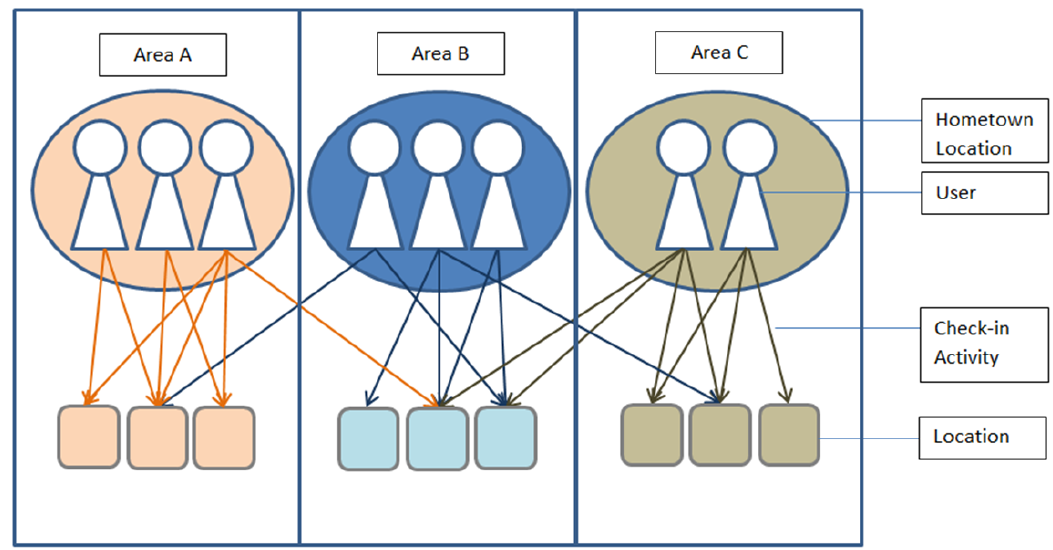
Figure 2. A graph of native users’ check-in activity in a location-based recommender